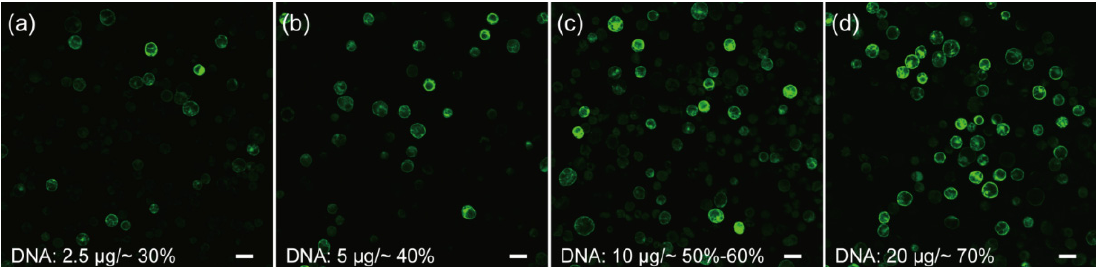
Figure 4. Influences of plasmid amounts on the transformation rates of C. pumila mesophyll proto- plasts. Protoplasts transformed with ( a ) 2.5 μ g results in an efficiency of ~30%, ( b ) 5 μ g, ( c ) 10 μ g, and ( d ) 20 μ g plasmids with corresponding transformation efficiencies of ~40%, ~60%, and ~70%, respectively. Scale bars, 50 μ m.